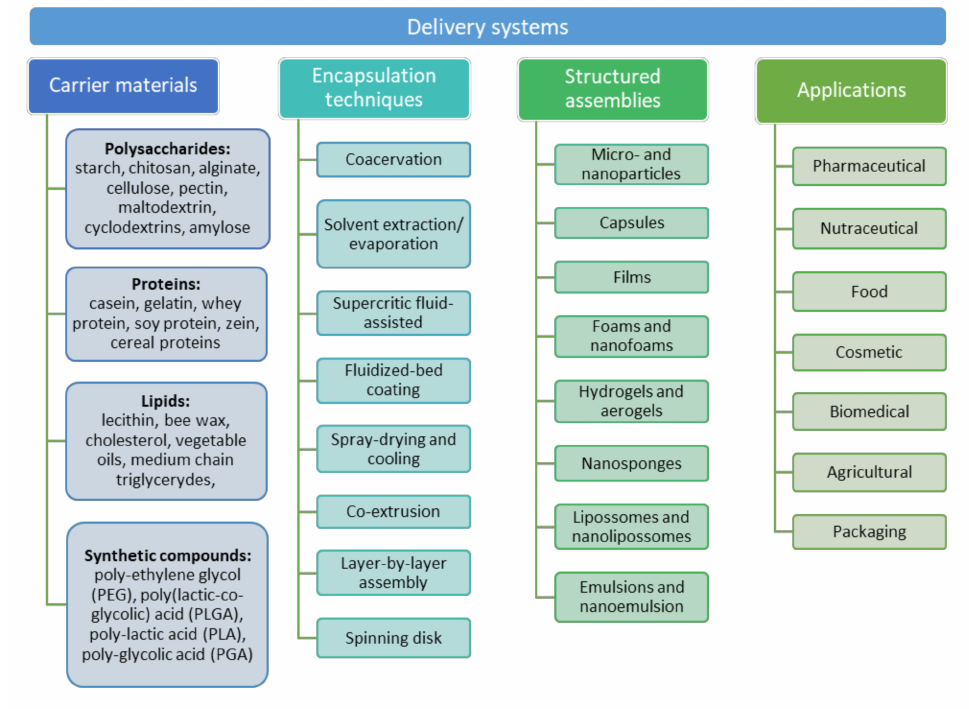
Figure 1. Systematic overview of encapsulating materials, techniques, structured assemblies, and applications of delivery